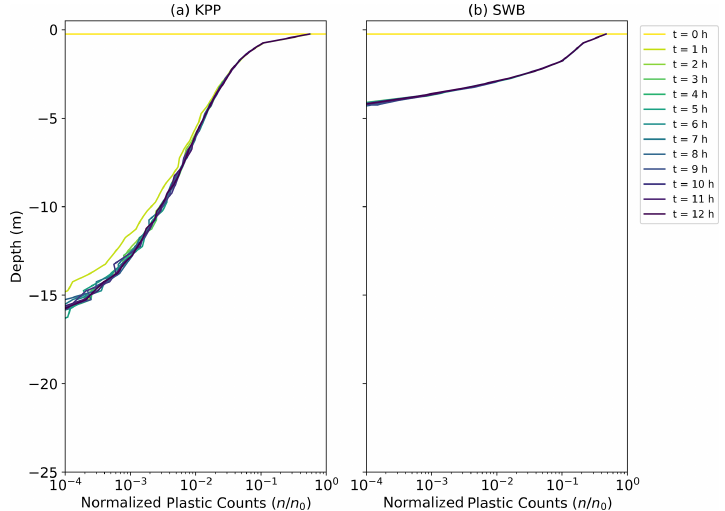
Figure C1. Vertical concentrations of buoyant particles for KPP diffusion at times t = 0–12h. The KPP diffusion profile is calculated with θ = 1 . 0, u 10 = 6 . 65ms − 1 , and z 0 according to Eq. (12).